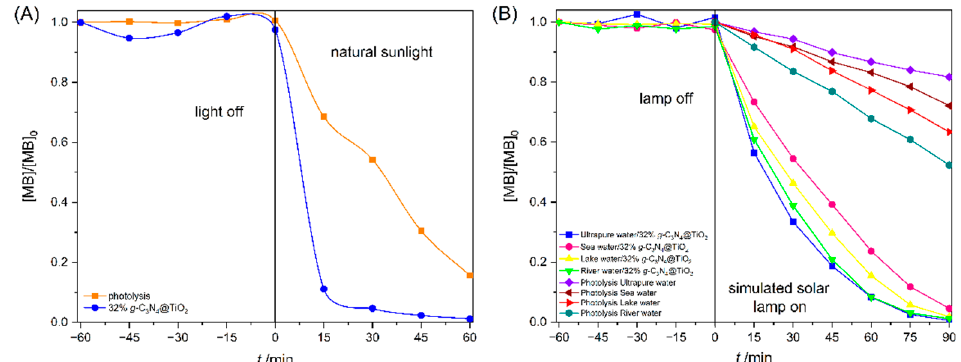
Figure 7. ( A ) Effect of natural sunlight irradiation on MB degradation and ( B ) Effect of different water bodies (ultrapure water, seawater, lake water, and river water) on the degradation efficiency of MB using 32% g -C 3 N 4 @TiO 2 under simulated solar irradiation.